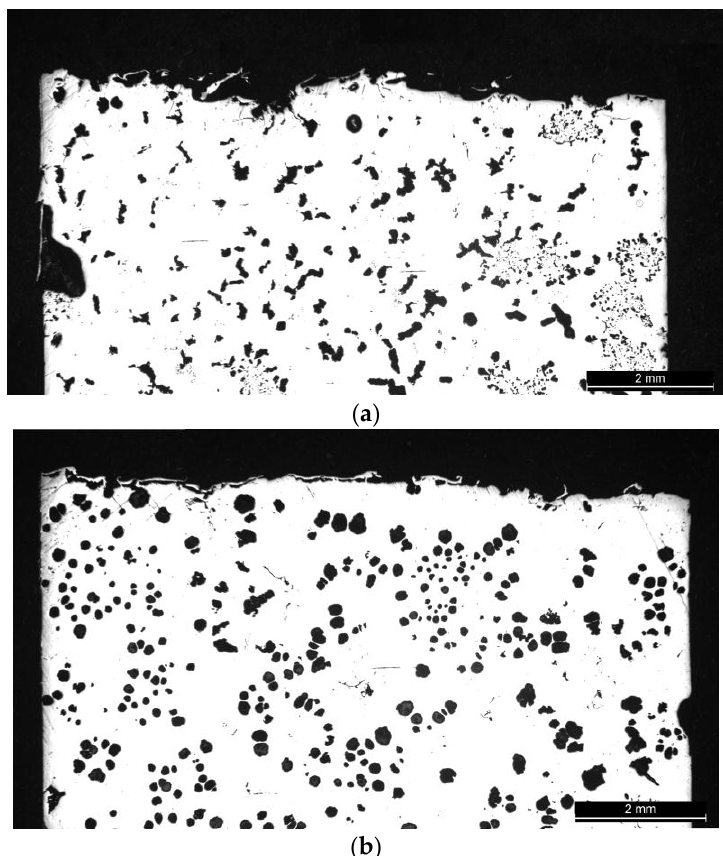
Figure 9. Light microscope images of crack front profiles taken in the near-threshold crack propagation region: ( a ) cross-section with significant presence of chunky graphite; and ( b ) cross-section with prevailing nodular graphite. Crack path direction is normal to paper plane.